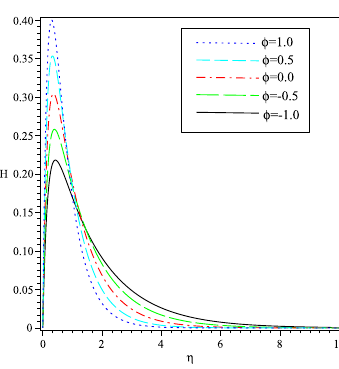
Fig. 5: The profile micro-rotation H ( η ) obtained by the direct RBFs for different values of ϕ at β = 6 and ε = 0.1